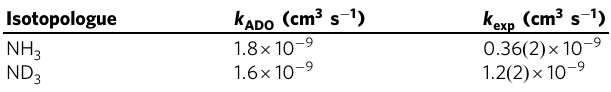
Table 1 ADO and experimental rate constants for the two ammonia isotopologues of interest.